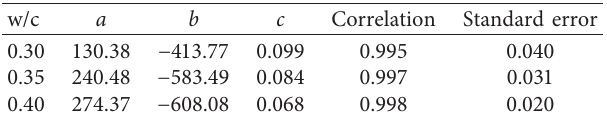
Table 7: Fitting parameters and correlation of pure cement pastes with different w/c.